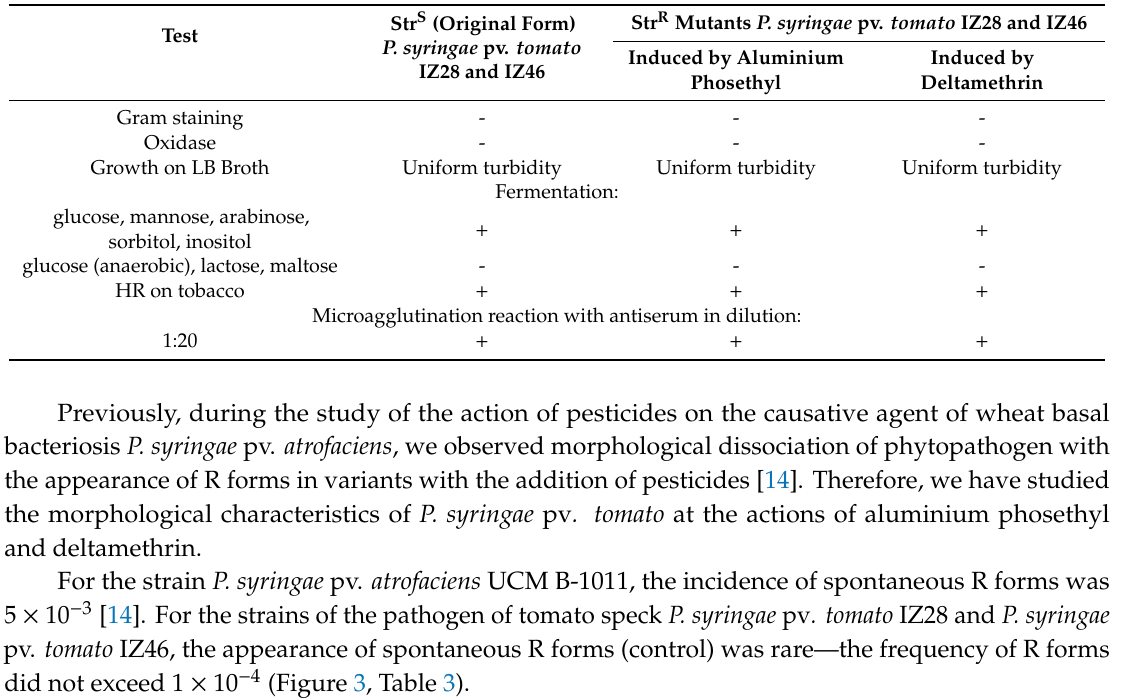
Table 2. Physiological and biochemical properties Str R mutants of P. syringae pv. tomato